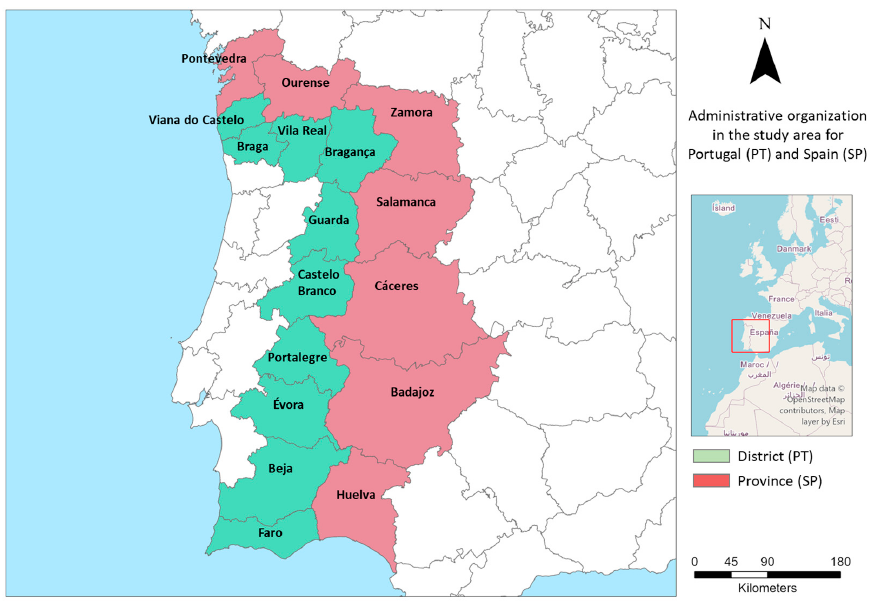
Figure 3. Administrative organization in the study area for Portugal (PT) and Spain (SP). The green area represents the Portuguese districts, and the red area represents the Spanish provinces.